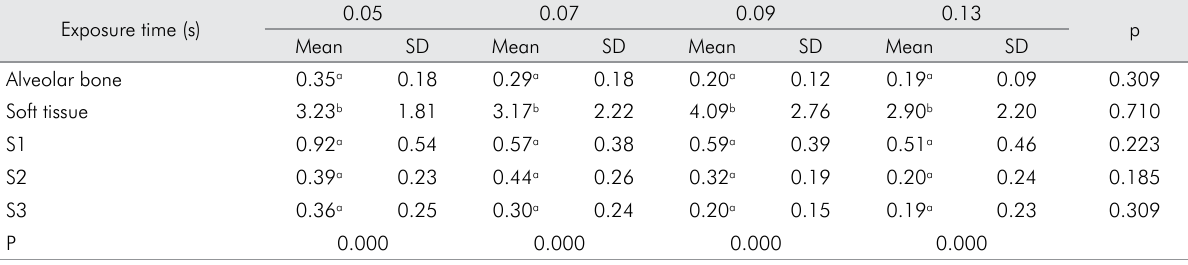
Table 2. Comparison of the reproducibility of the gray values in the various exposure times and ROIs. Exposure time (s) Alveolar